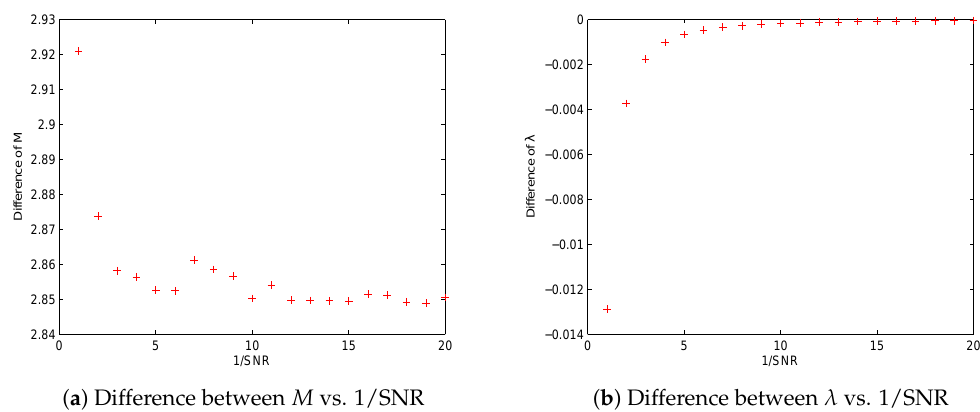
, NP 1 ) and (NP 1 ) with SNR = 1 k (cid:102)